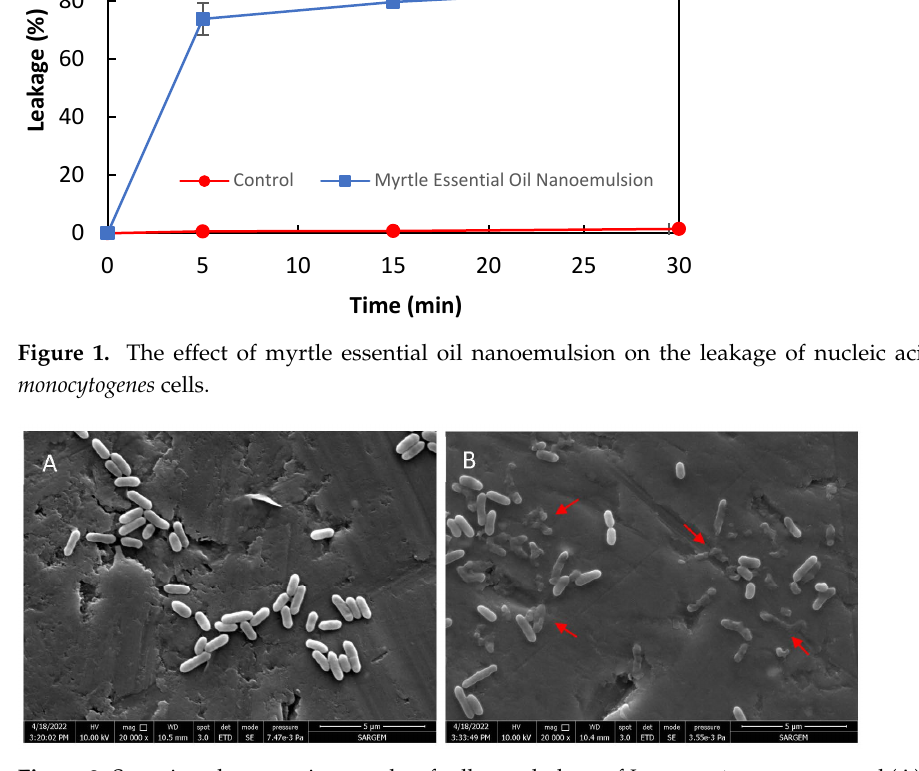
Figure 1. The effect of myrtle essential oil nanoemulsion on the leakage of nucleic acids of L. mono- cytogenes cells.